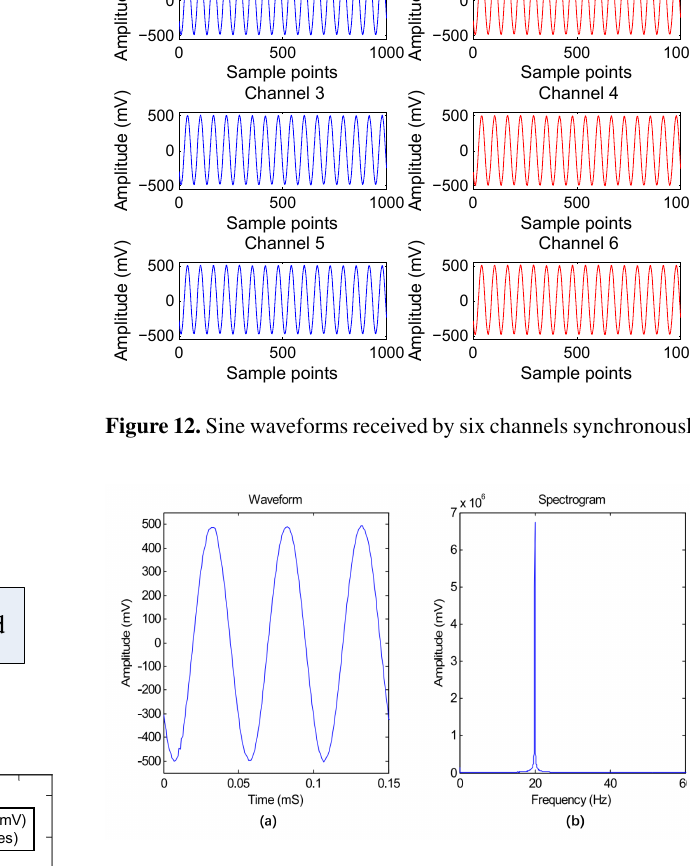
Figure 13. Waveform and its spectrum